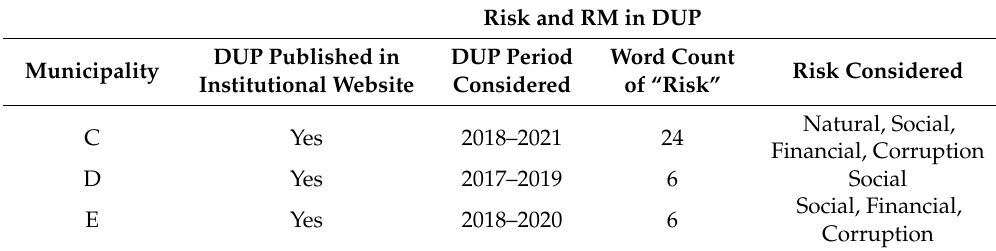
Table 5. Analysis of DUP in Municipalities C, D and E. Risk and RM in DUP DUP Published in In- Municipality